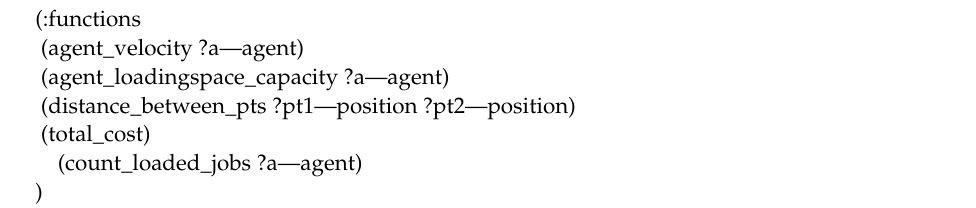
Algorithm 2 Function definition of MDCOVRPPD planning domain description.